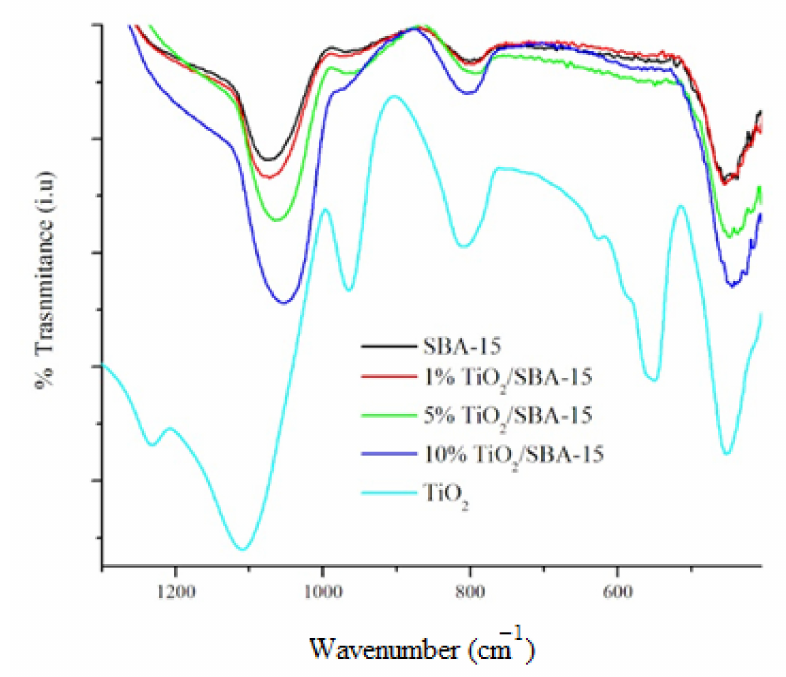
Figure 3. FTIR spectra of SBA-15 and after impregnation with titania. Table 1. FTIR analysis data from samples of SBA-15 before and after titania